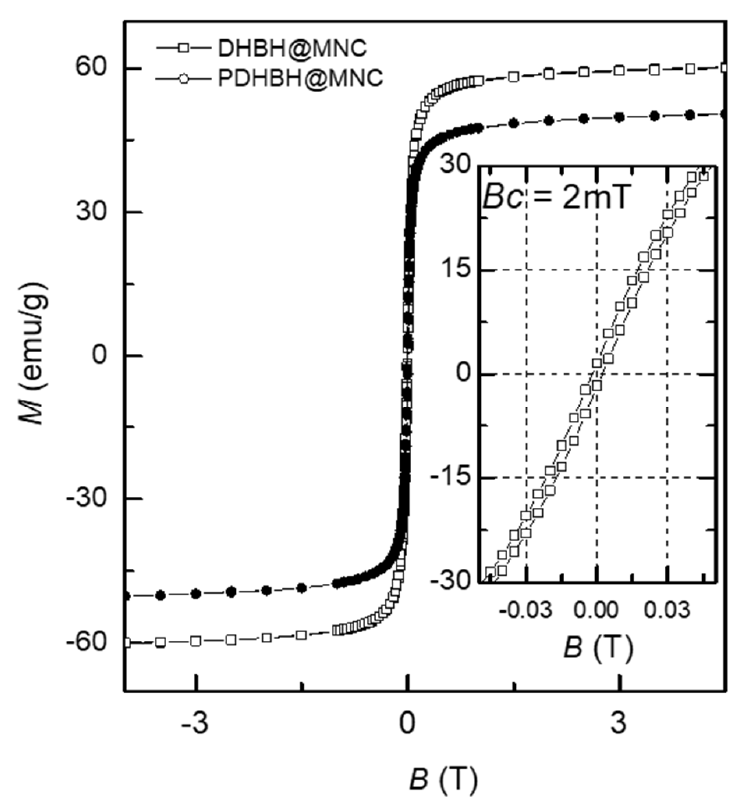
Figure 4. Magnetic hysteresis loops of both types of MNC. Inset is the low-field regime of the hysteresis loops.